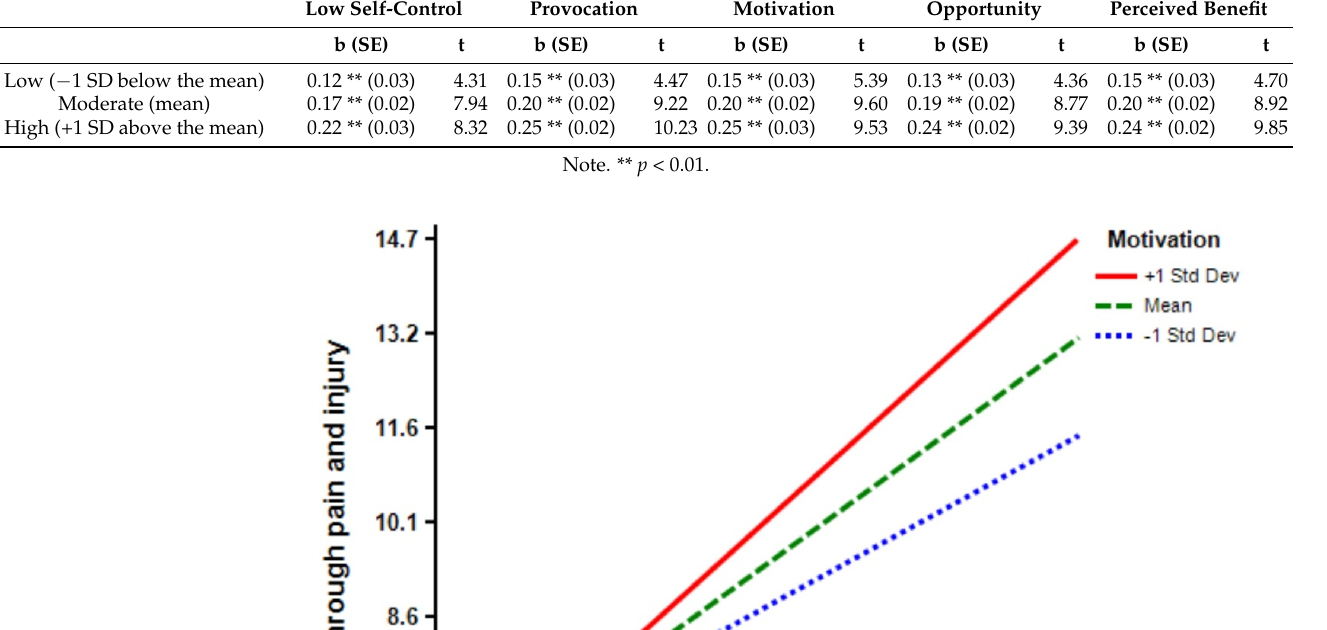
Figure 6. Opportunity by control balance deficit interaction.